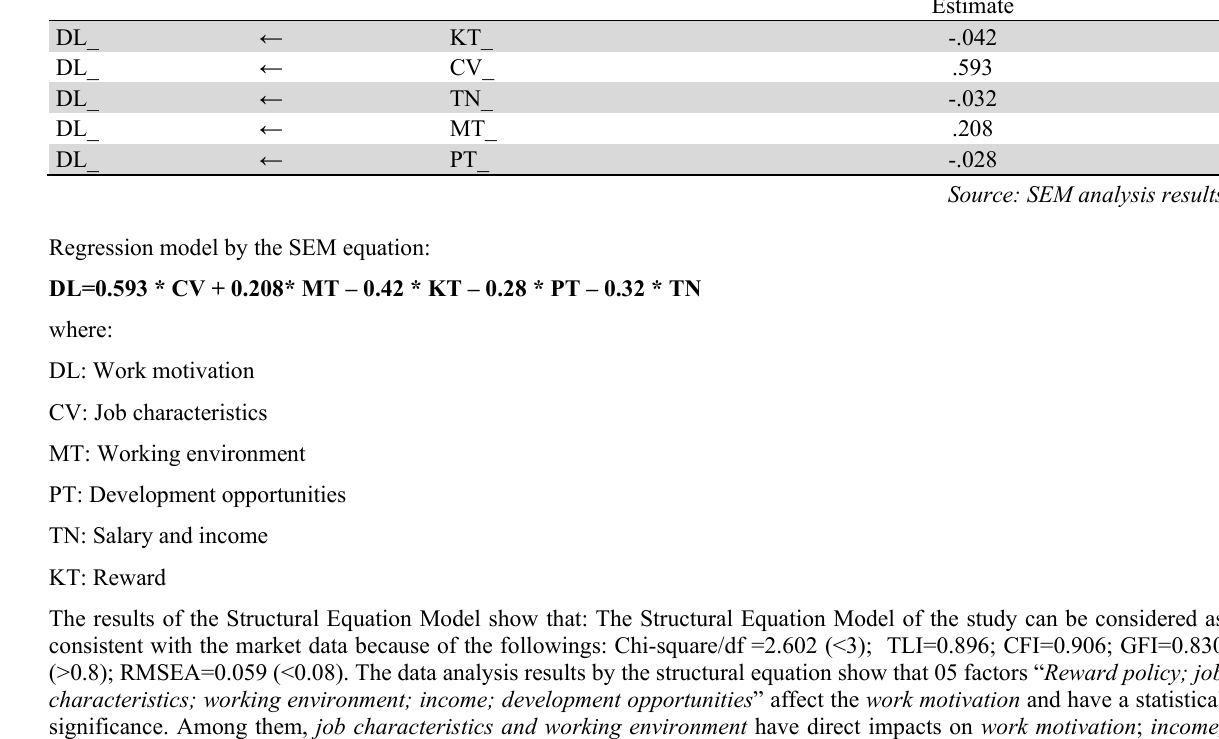
Table 7 Standardized regression weights (Group number 1 - Default model)